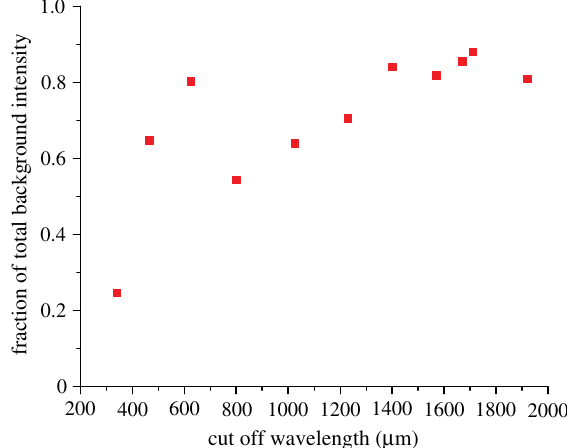
FIG. 4. Approximate wavelength distribution of the back- ground radiation. Note that wavelengths longer than about 2.8 mm cannot be detected by the optical system.